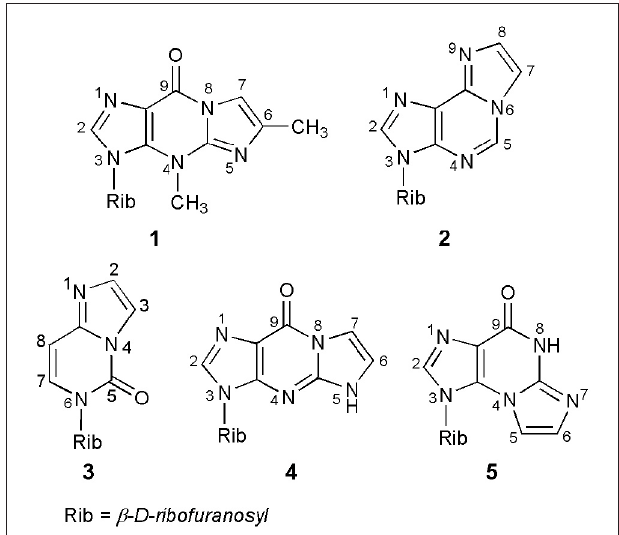
FIGURE 1 | Naturally occurring wyosine (1) and synthetic ethenonucleosides.